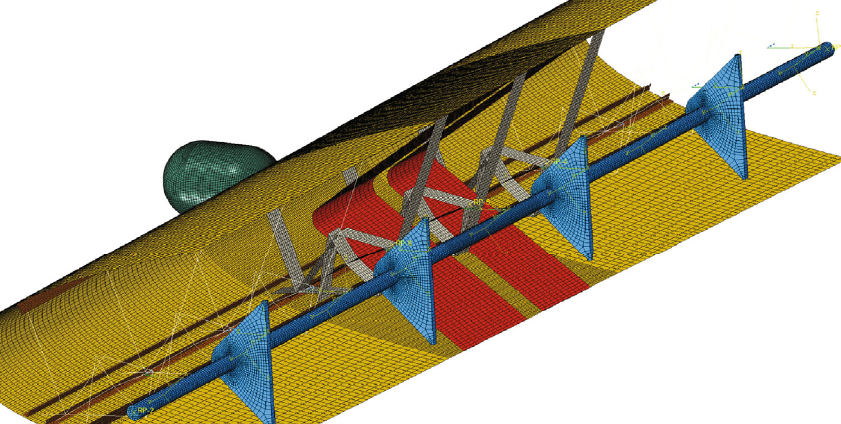
Figure 26: Testing facility for the bird impact simulation on the overall LE structure.